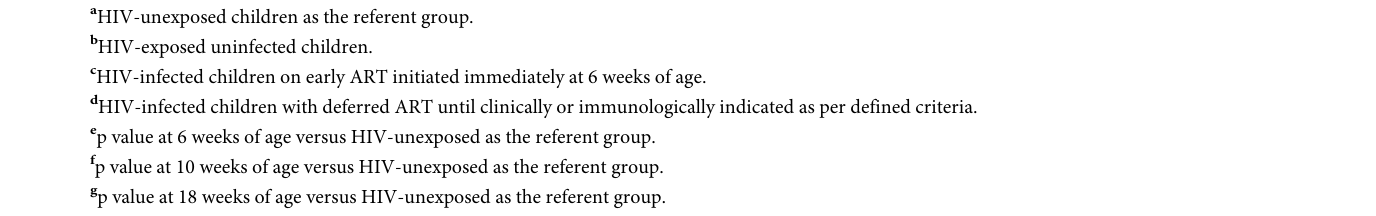
Table 2. At this time point, the seroconversion rate in HIV+/ART+ infants was higher than